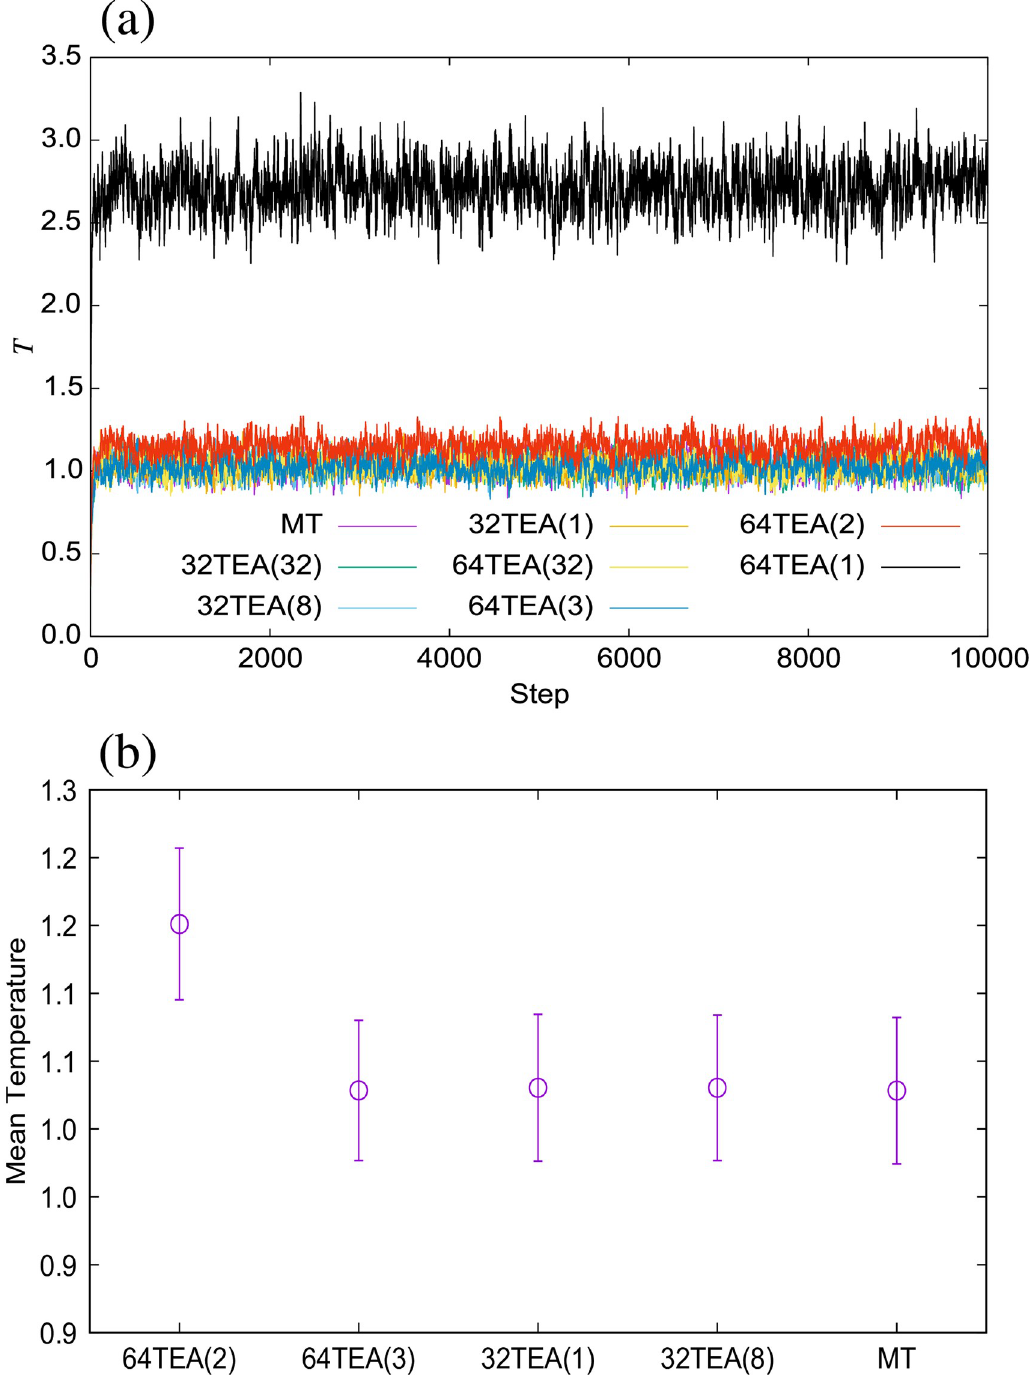
Fig 3. (a) Temperature of the water system, (b) mean temperature and its fluctuations.